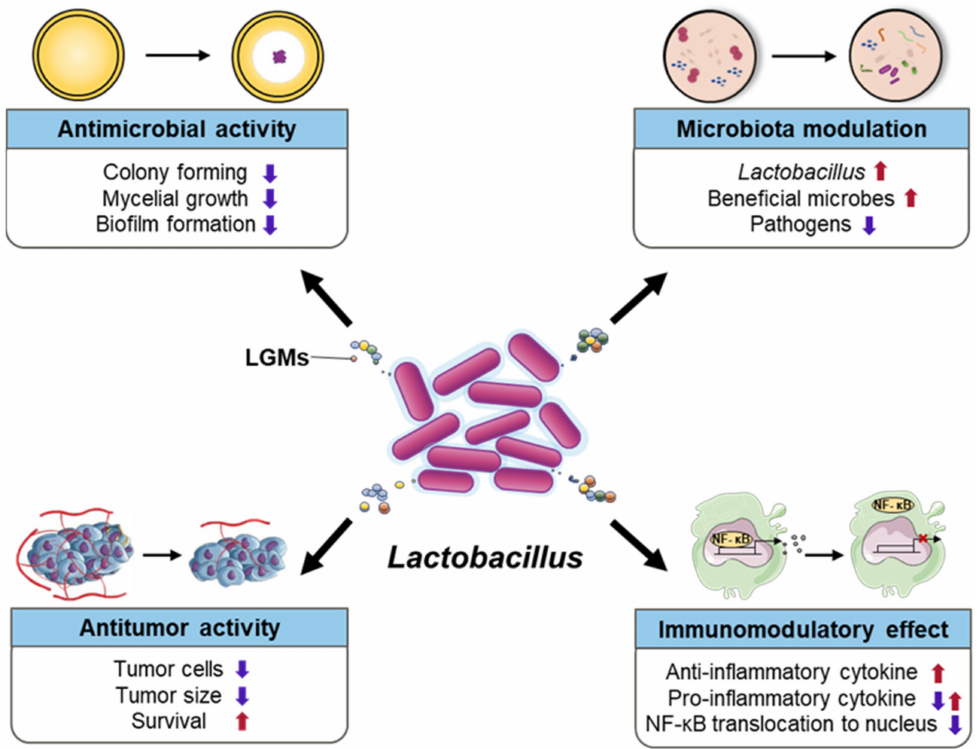
Figure 1. Various disease control mechanisms of the genus Lactobacillus . LGMs indicate Lactobacillus generated